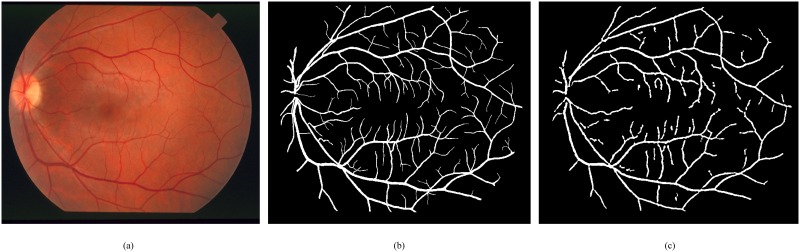
Visual appearance of the proposed technique utilizing STARE dataset.(a) RGB photograph (b) Manual segmentation (c) Proposed technique segmented image.